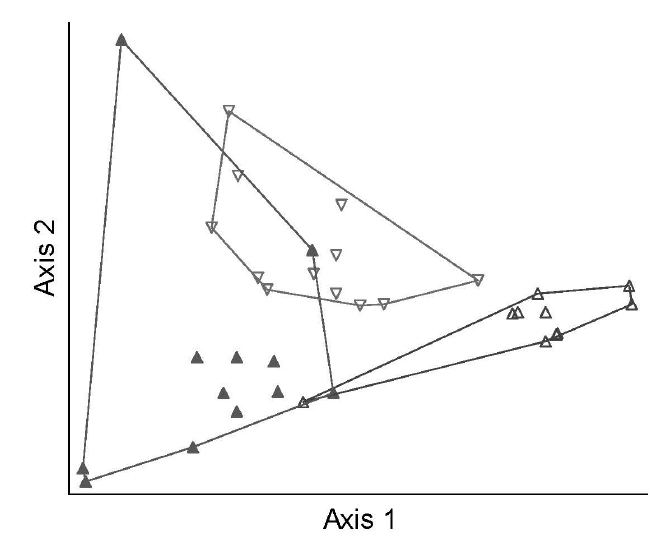
Figure 9. Detrended correspondence analyse (DCA) analysis of plot composition; up empty triangles indicate natural pine forest communities; up solid triangles indicate pine communities with Sambucus nigra ; down empty triangles indicate Sambucus racemosa communities.